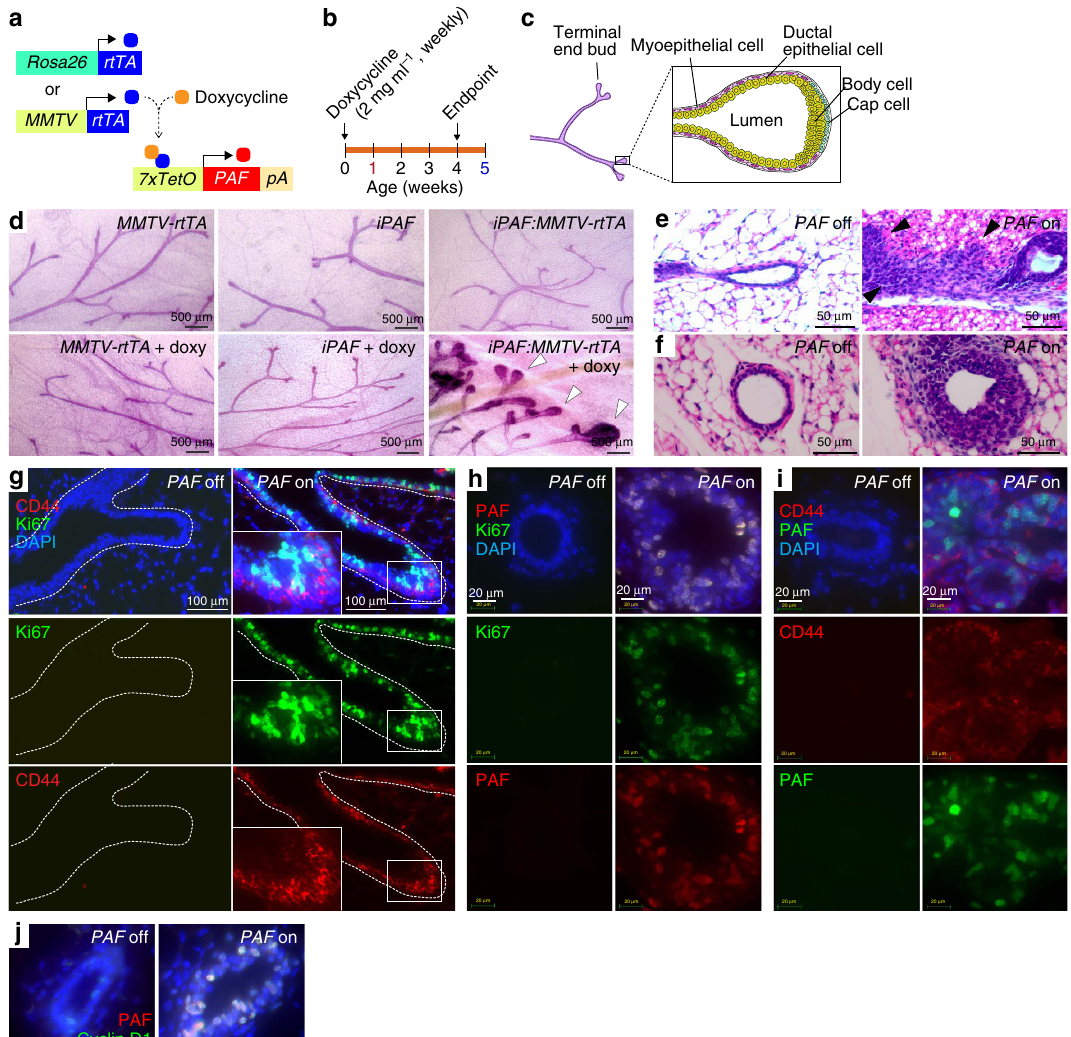
Figure 3 | Mammary ductal hyperplasia by PAF conditional expression. ( a ) Schematic diagram of PAF -inducible mouse models. For MEC-specific induction of PAF , MMTV-rtTA driver was bred with iPAF strain. On doxycycline treatment in drinking water, activated rtTA binds to TetO and transactivates PAF expression in MECs. Alternatively, Rosa26-rtTA strain was used. ( b ) Doxycycline administration strategies. Doxycycline was administrated in drinking water (5% sucrose) for each time point. ( c ) Illustration of mammary duct structure. ( d – f ) Ductal hyperplasia by PAF conditional expression. MMTV-rtTA:iPAF (experimental group) or MMTV-rtTA (control) mice were treated with doxycycline (2mgml (cid:3) 1 ) for 30 days after weaning. Longitudinal ( d ) or transverse ( e ) sectioned mammary glands were stained with haematoxylin and eosin. Arrowheads (white): hyperplastic TEBs; arrowheads (black): infiltrated ductal epithelial cells ( f ). Hyperproliferation of ductal epithelial cells by PAF. Ki67 immunostaining of longitudinal section. Scale bars, 500 m m ( d ); 50 m m ( e , f ). ( g – i ) Upregulation of CD44 by conditional expression of PAF. Ki67 (green) and CD44 (red) immunostaining of mammary ducts. To exclude indirect effects of PAF expression on cell proliferation, doxycycline was administrated for 7 days instead of 30 days. Scale bars, 100 m m ( g ); 20 m m ( h , i ). ( j ) Upregulation of Cyclin D1 by conditional expression of PAF. Doxycycline treated for 7 days. Scale bars, 20 m